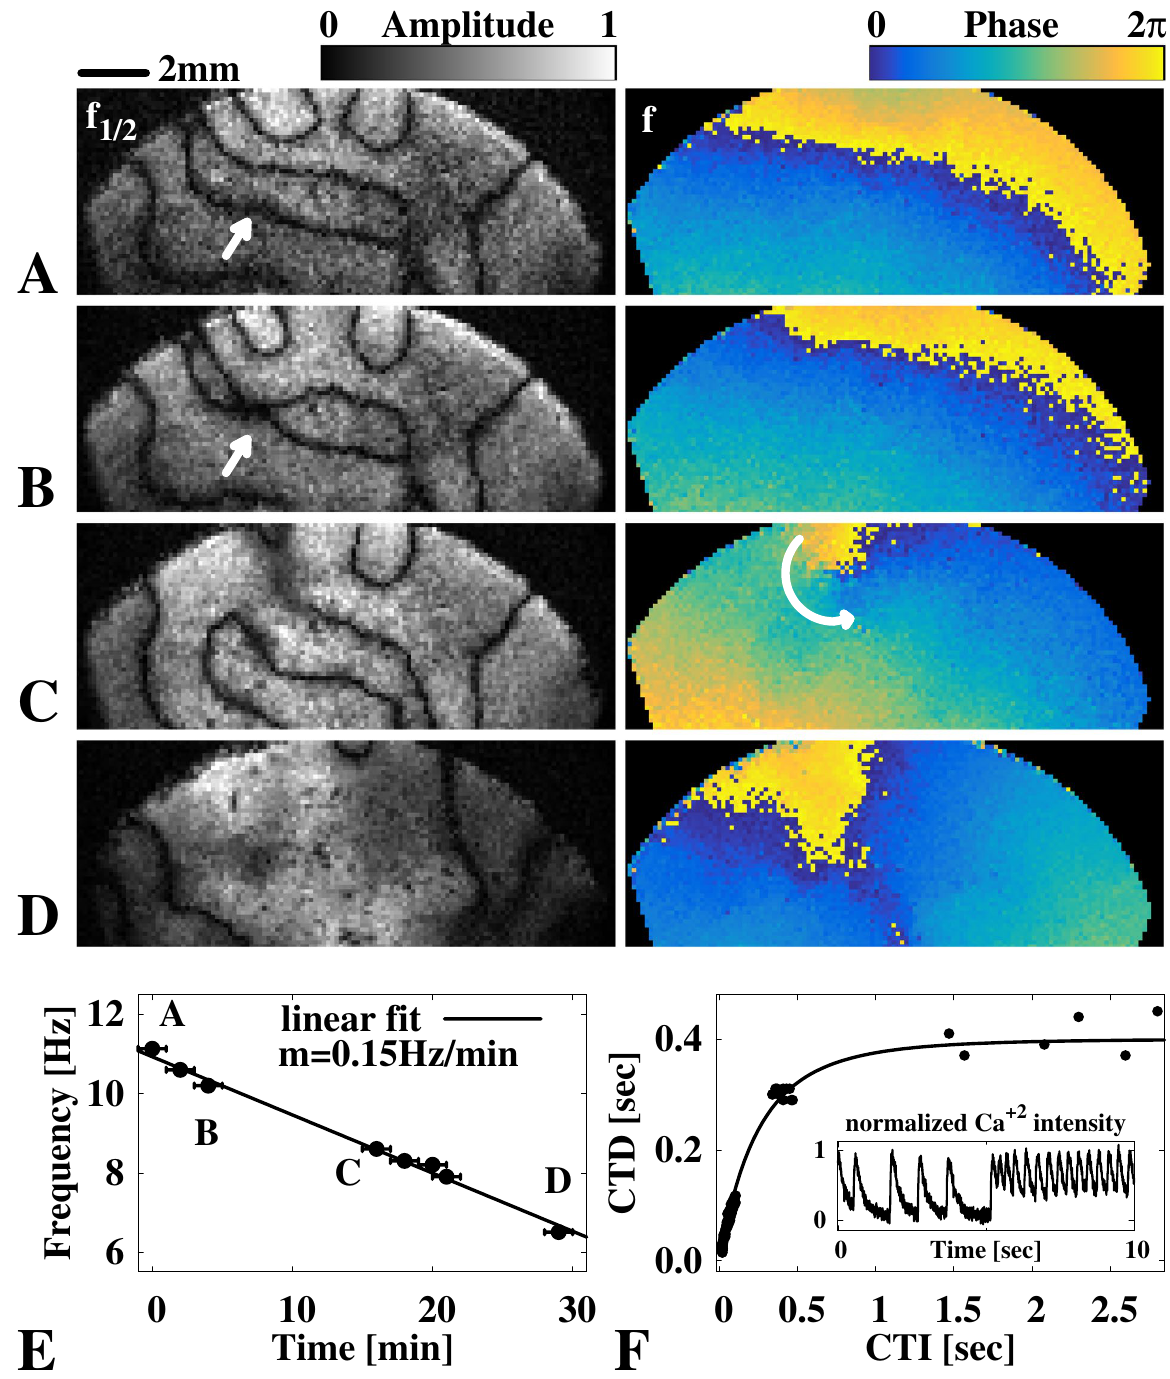
Figure 5. Spatiotemporal nodal line dynamics in a cardiomyocyte tissue. ( A to D ) show the amplitude ( f 1/2 ) and phase space ( f ) of the spatiotemporal evolving nodal line dynamics of the free spiral wave (see Fig. 4C). A and B show the merging of a nodal line (white arrow). ( C ) shows the anisotropic merging after a nodal line break, which temporally induces a locally confined spiral wave (white curved arrow). ( D ) shows wave-curvature dominant dynamics induced by the linear decay of the spiral frequency f . The temporal change of f is shown in ( E ) within a time window of 30 minutes. ( F ) shows the estimated restitution curve of the cytosolic calcium dynamics extracted from A (CTD < 0.2 sec) and spontaneous wave activity (CTD > 0.2 sec) before the creation of the concordant alternans spiral wave. The latter is shown as an intensity time series in the